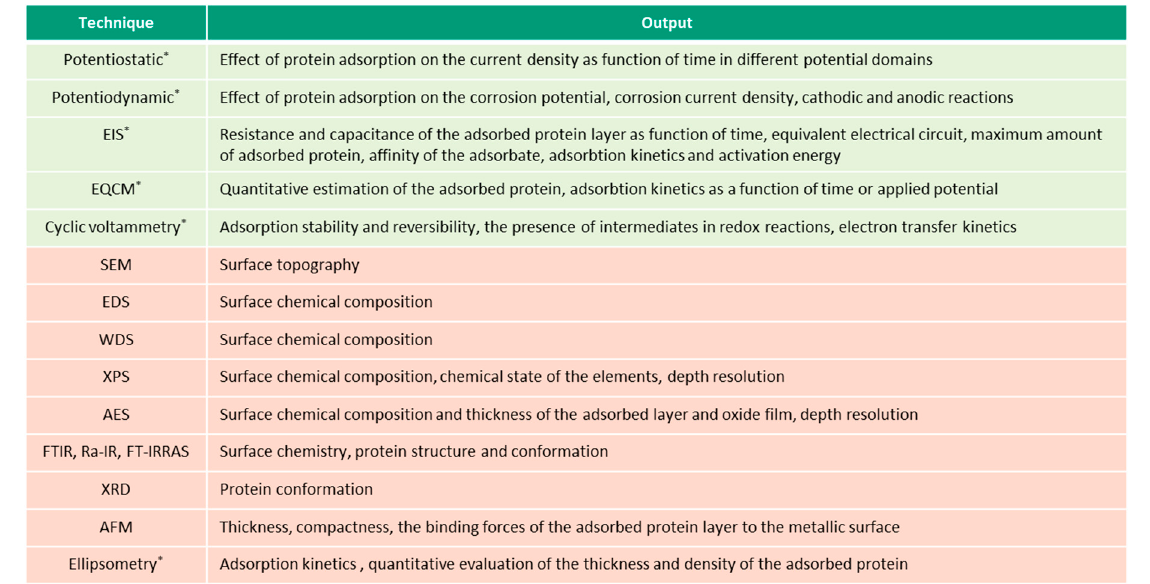
Figure 2. Techniques (in green—electrochemical, in-red—microscopic and spectroscopic) used for investigation of albumin adsorption on biomedical alloys, (* in-situ techniques). Materials 2020 , 13 , 4858